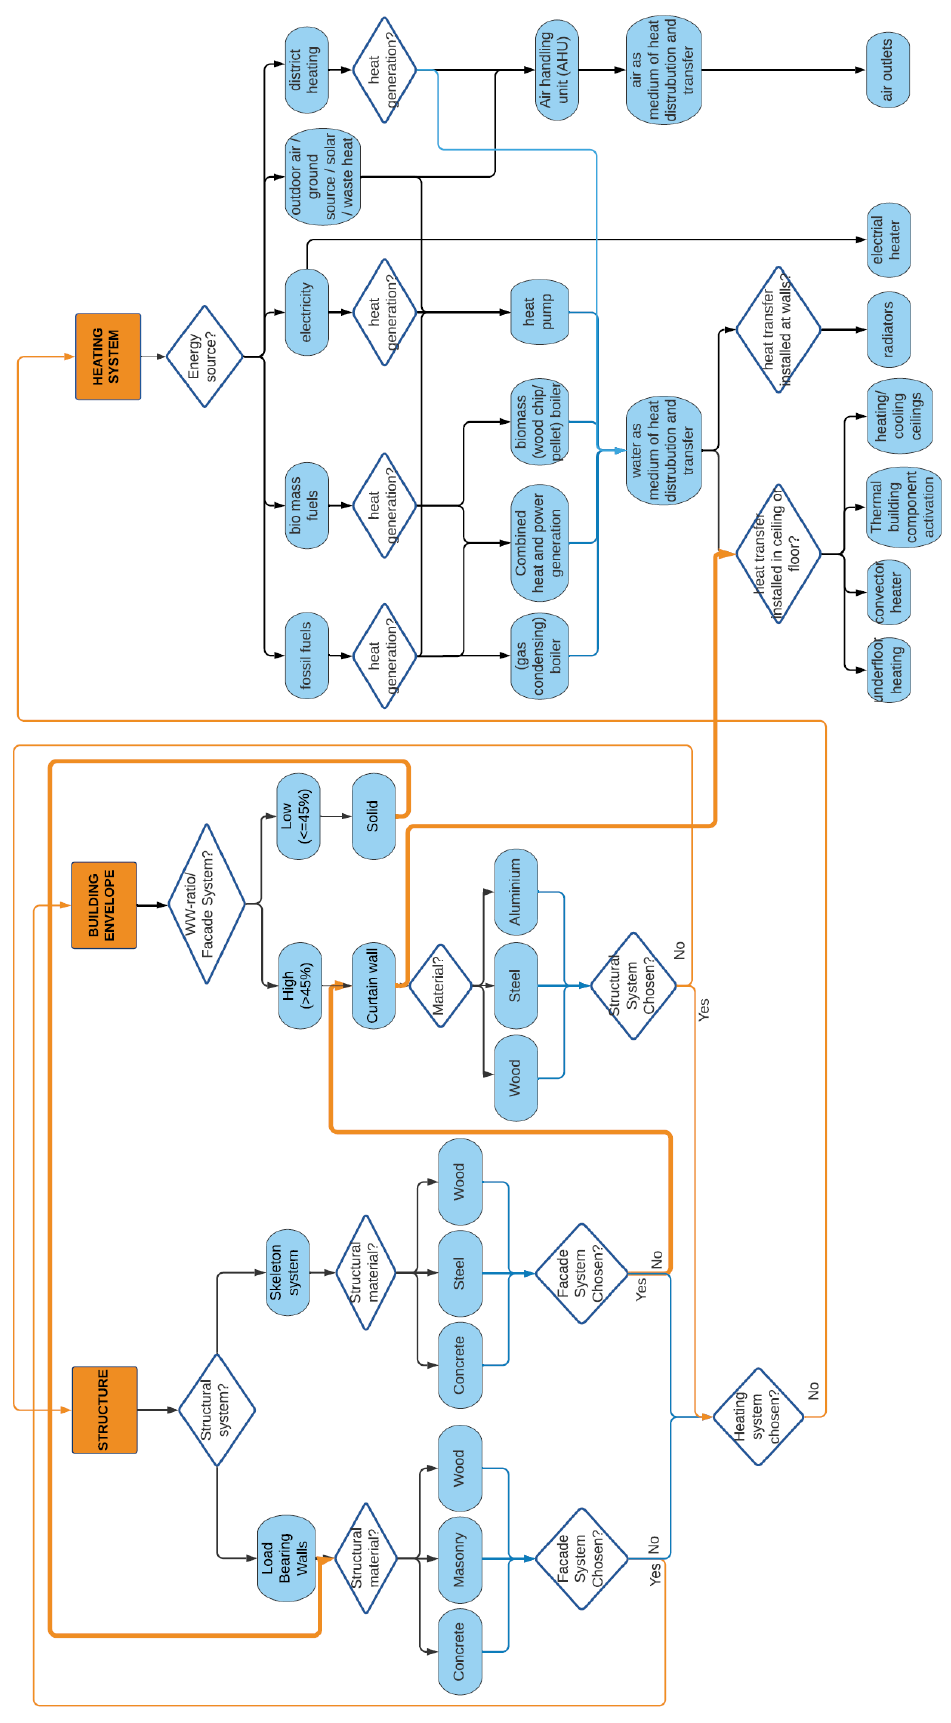
Figure 3. A case study of a CDDN in an early design phase for conceptual decision